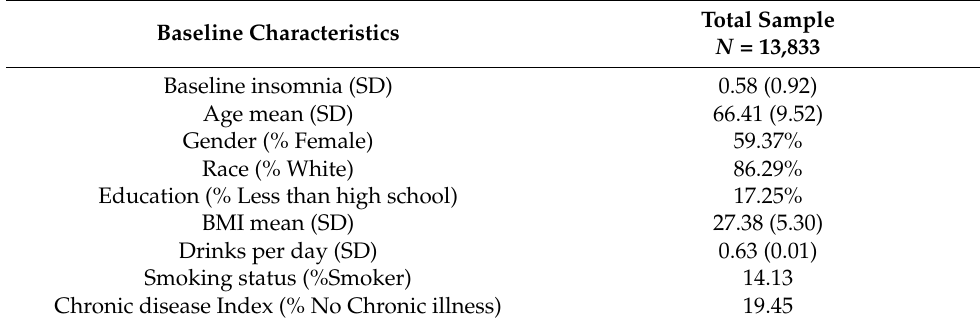
Figure 1. Fluctuation of self-reported insomnia symptoms over time (2002–2014). Different colors indicate the classification of information (yellow: no or 0 self-reported insomnia symptoms; blue = 1 self-reported insomnia symptom; purple = 2 self-reported insomnia symptoms; green = 3 self-reported insomnia symptoms; orange = 4 self-reported insomnia symptoms). Classification of insomnia symptoms is limited to 0 or 1 insomnia symptom(s) in 2008 and 2012. Changes of self-reported insomnia symptoms are represented by curved lines. Data source: Health and Retirement Study (2002–2014). Table 1. Baseline sample characteristics.